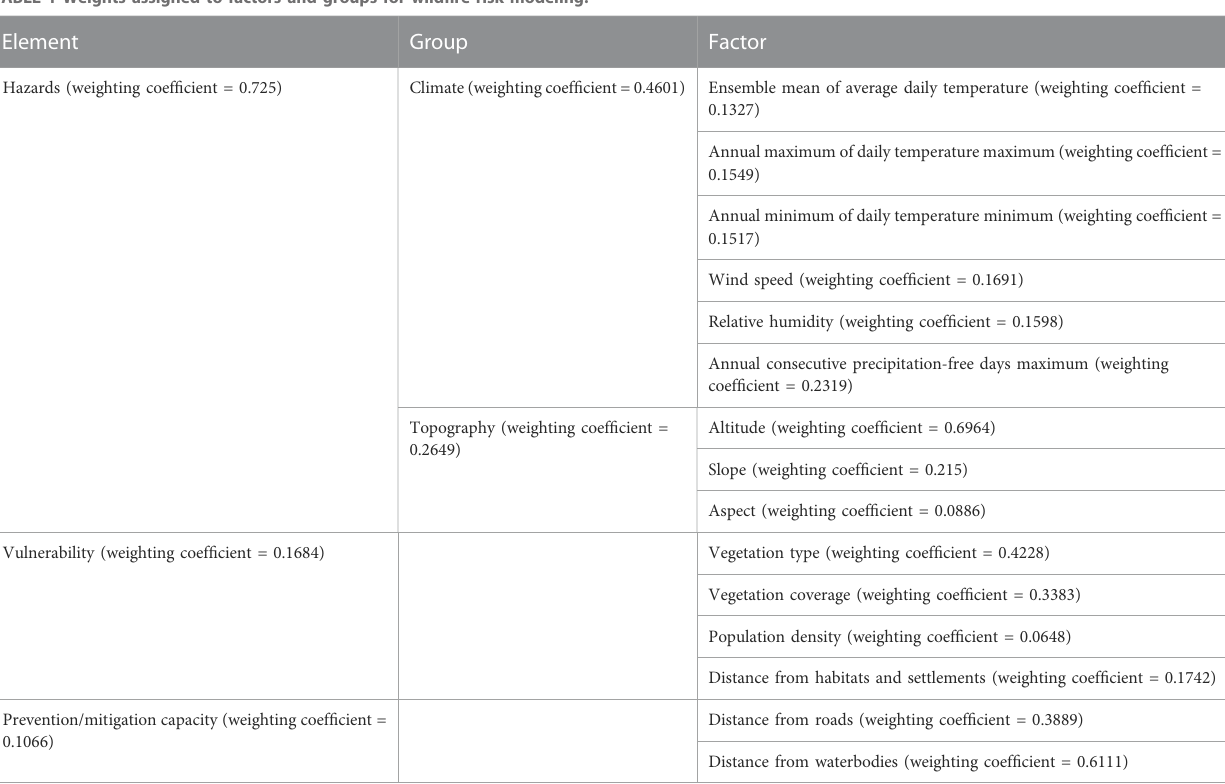
TABLE 1 Weights assigned to factors and groups for wild fi re risk